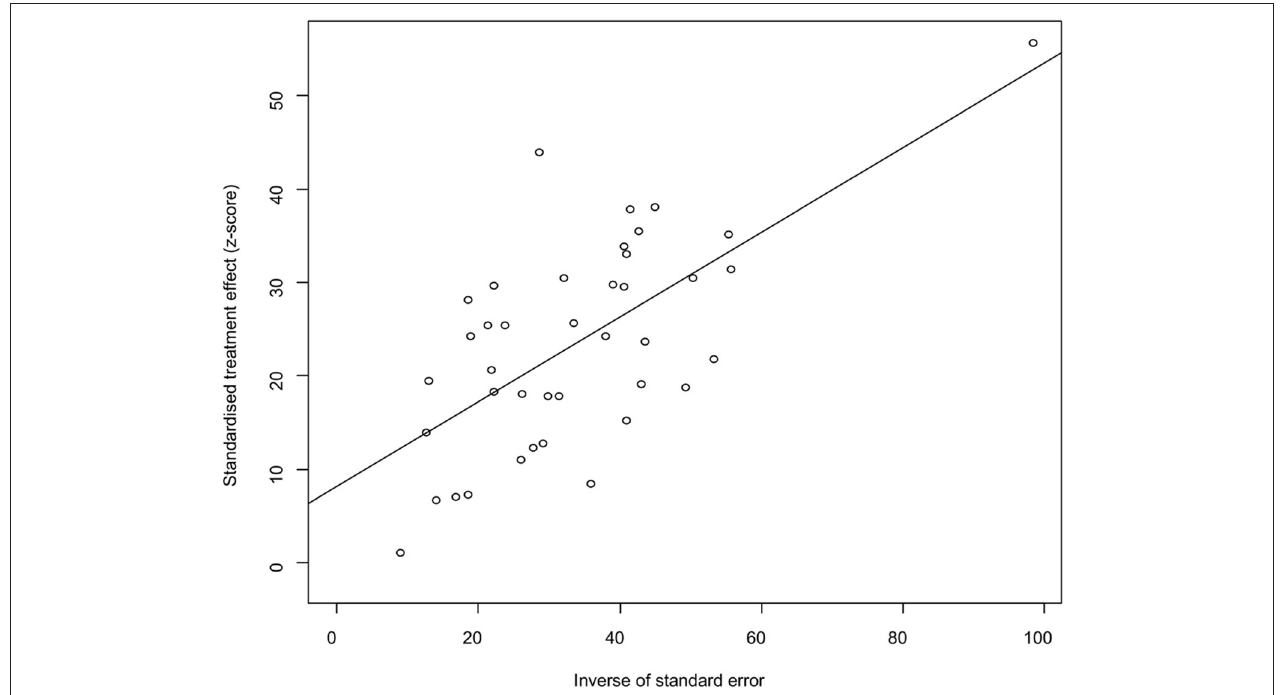
FIGURE 6 | Egger’s test for publication